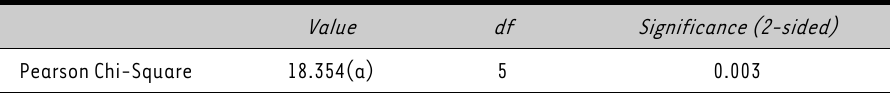
Chi-square tests Value df Significance (2-sided) Pearson Chi-Square 18.354(a) 0.003